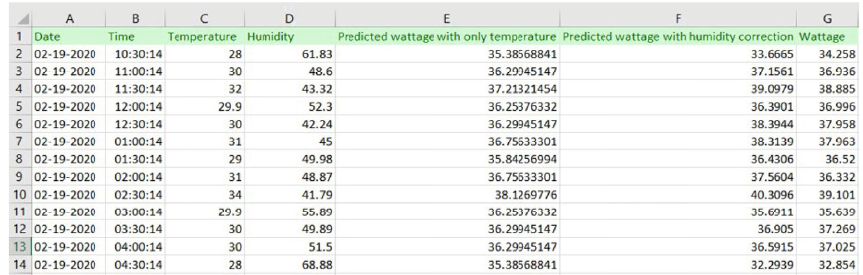
Figure 16: Testing predicted wattage with measured